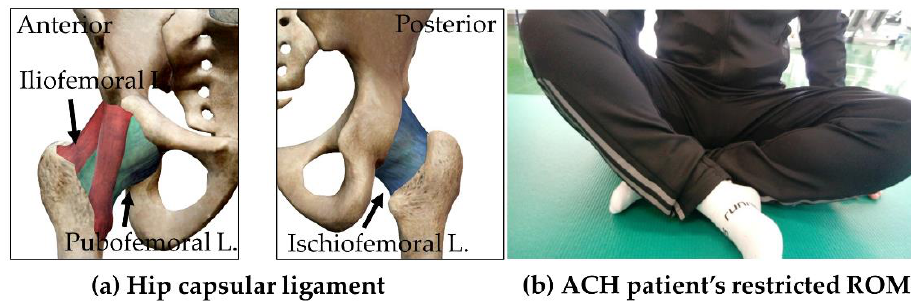
Figure 1. Hip capsular ligament anatomy and ACH patient’s characteristics .